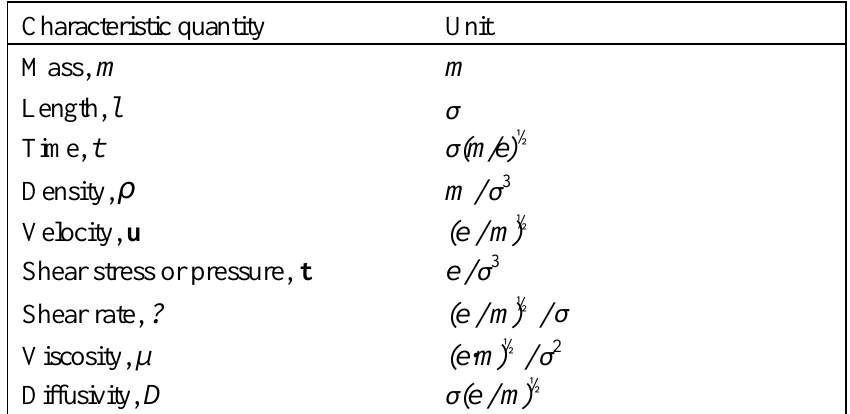
Table 1. Units of the characteristic